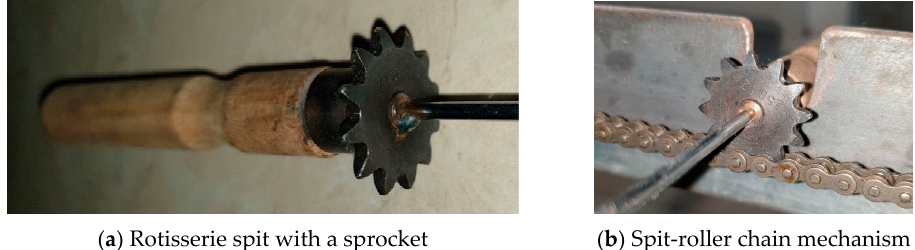
Figure 8. The rotisserie spit used for the spit ‐ roller chain engagement.